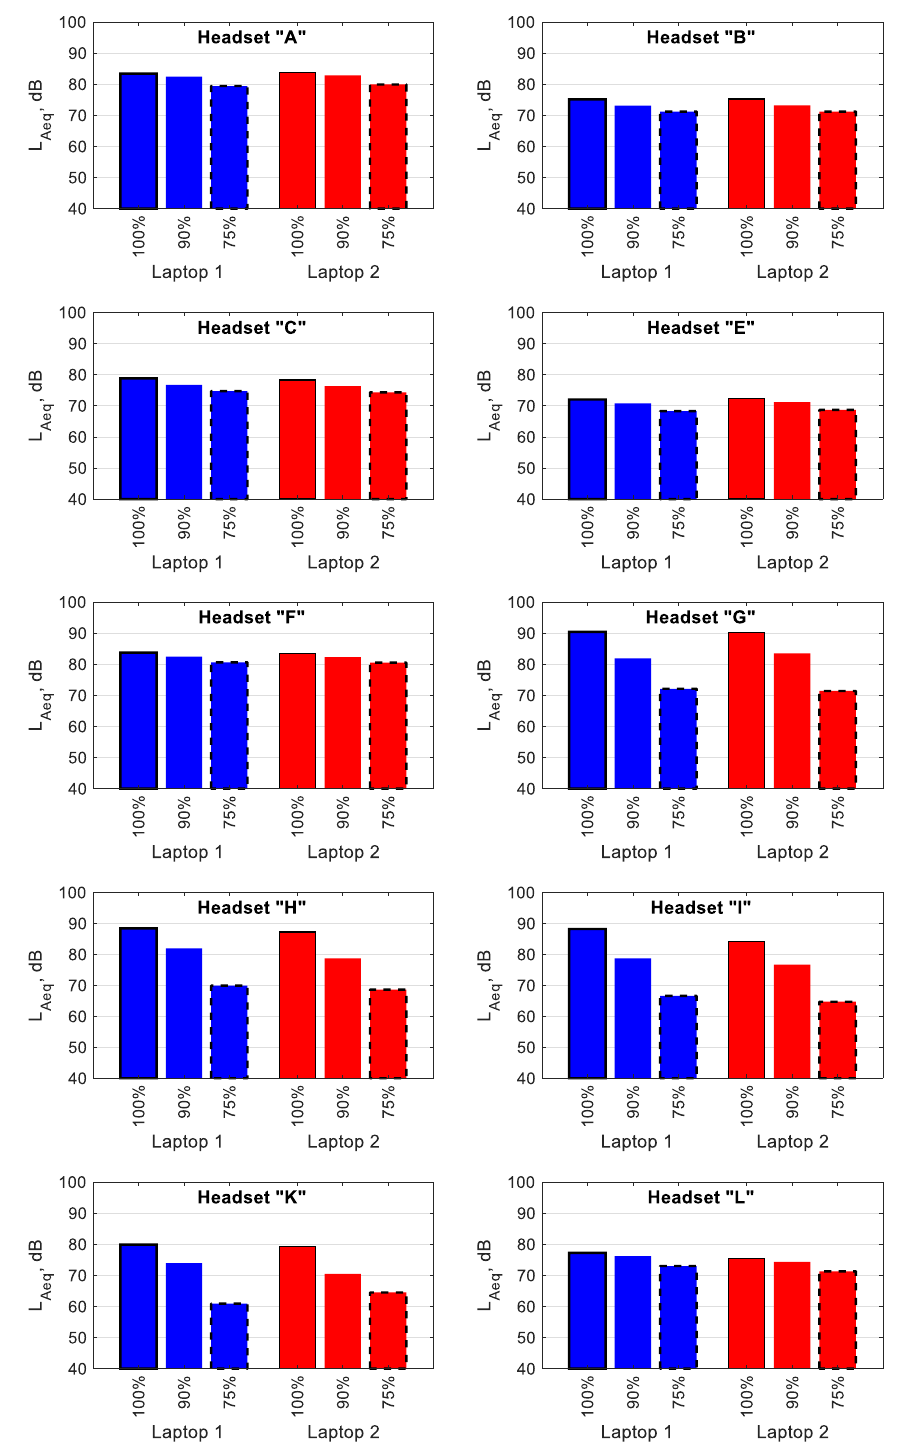
Figure 4. The values of A-weighted equivalent sound pressure level of the test signal reproduced by headsets connected to Laptop 1 and Laptop 2 via USB. The values given as percentages indicate the control level values of the test signal.